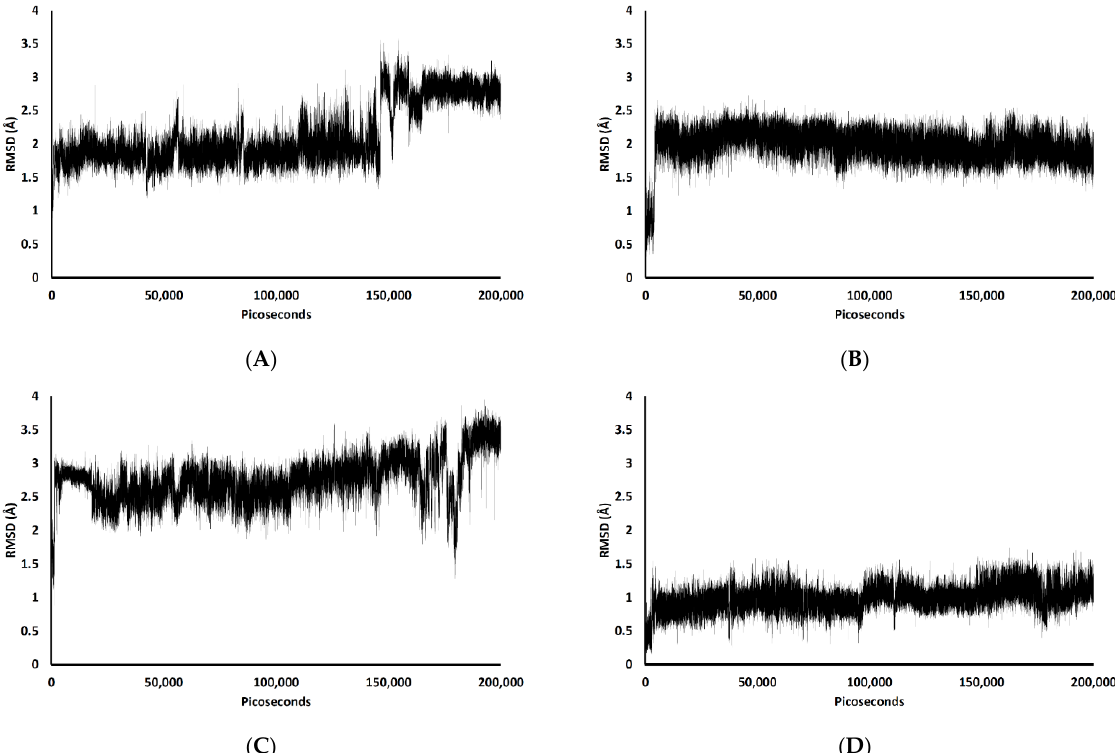
Figure 5. RMSD plots during the 200,000 ps simulation of the ligand coordinates from the ( A ) TGN1, ( B ) TGN2, ( C ) TGN3, and ( D ) TGN4 ‒ A β 1–42 monomer ‒ POPC bilayer models.